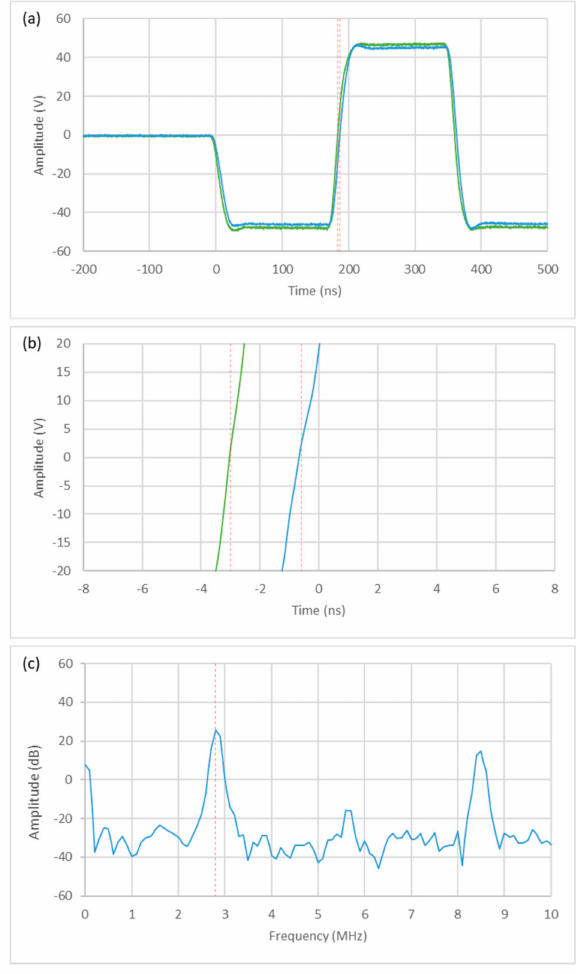
Figure 10. Delay and frequency resolution of two 2.82 MHz transmit signals shifted by 2 ns in the time domain (different oscilloscope resolutions) ( a , b ) and the spectrum of the transmit signal ( c ).